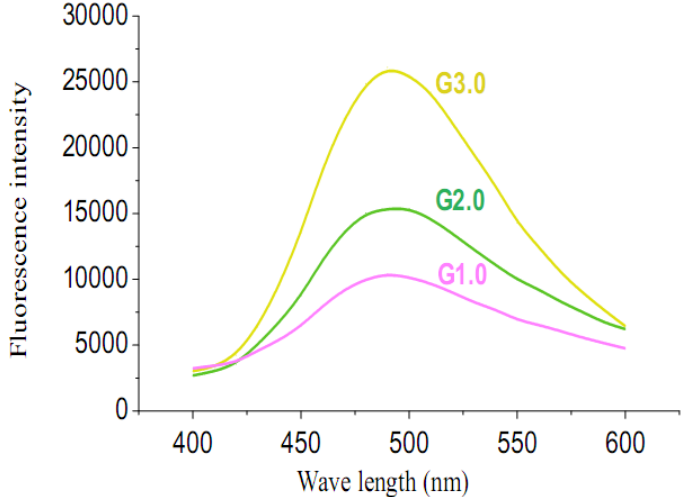
-I)/I ] × 100% of fluorescence intensity of G3.0 0 0